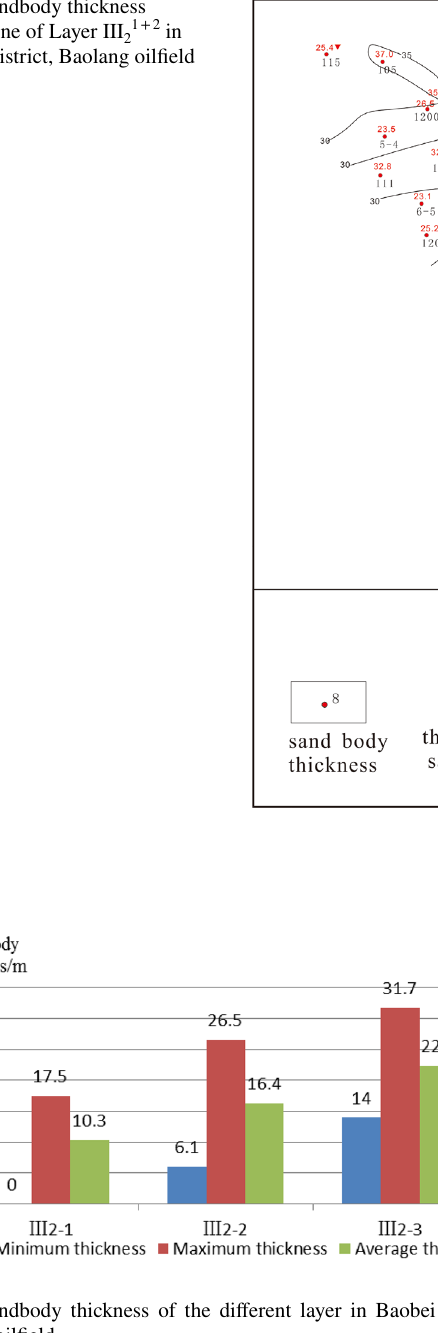
Fig. 8 Sandbody thickness contour line of Layer III 21 + 2 in